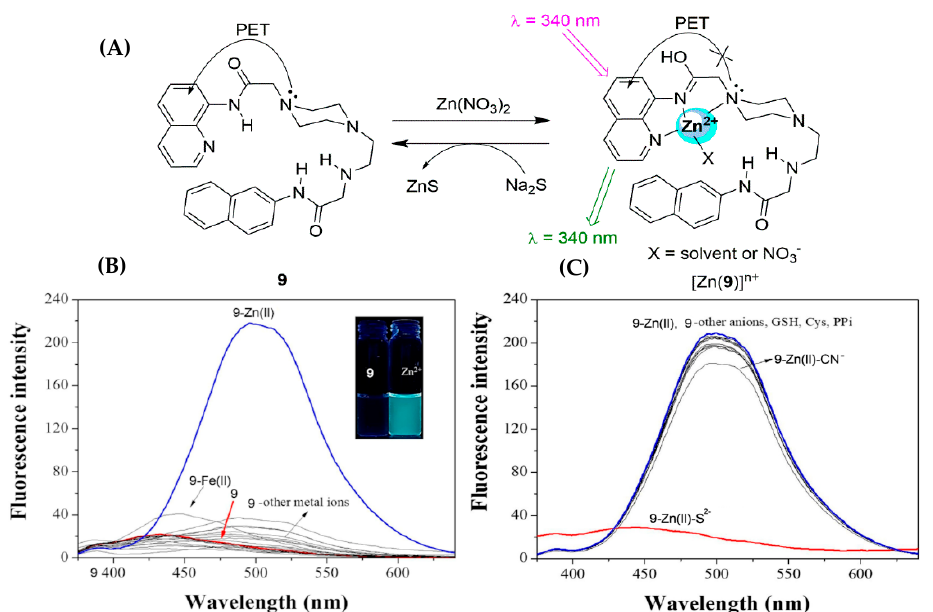
Figure 4. ( A ) Proposed binding mode of compound 9 and Zn 2 + ions. ( B ) Fluorescence changes observed for compound 9 (5 µ M) upon the addition of di ff erent metal salts (3.0 equivalents) in bis-tris bu ff er (10 mM, pH 7.0, λ ex = 340 nm) and ( C ) spectral changes of [Zn( 9 )(NO 3 )] + upon the addition of di ff erent anions added. Br − , BzO − , Cl − ClO − , CN − , F − , H 2 PO 4 − , I − , N 3 − , NO 2 − , OAc − , SCN − SO 42 − , HSO 4 − , pyrophosphate (PPi), cysteine, and glutathione (thiol containing amino acids). Adapted and reprinted from [149], with permission from Elsevier.